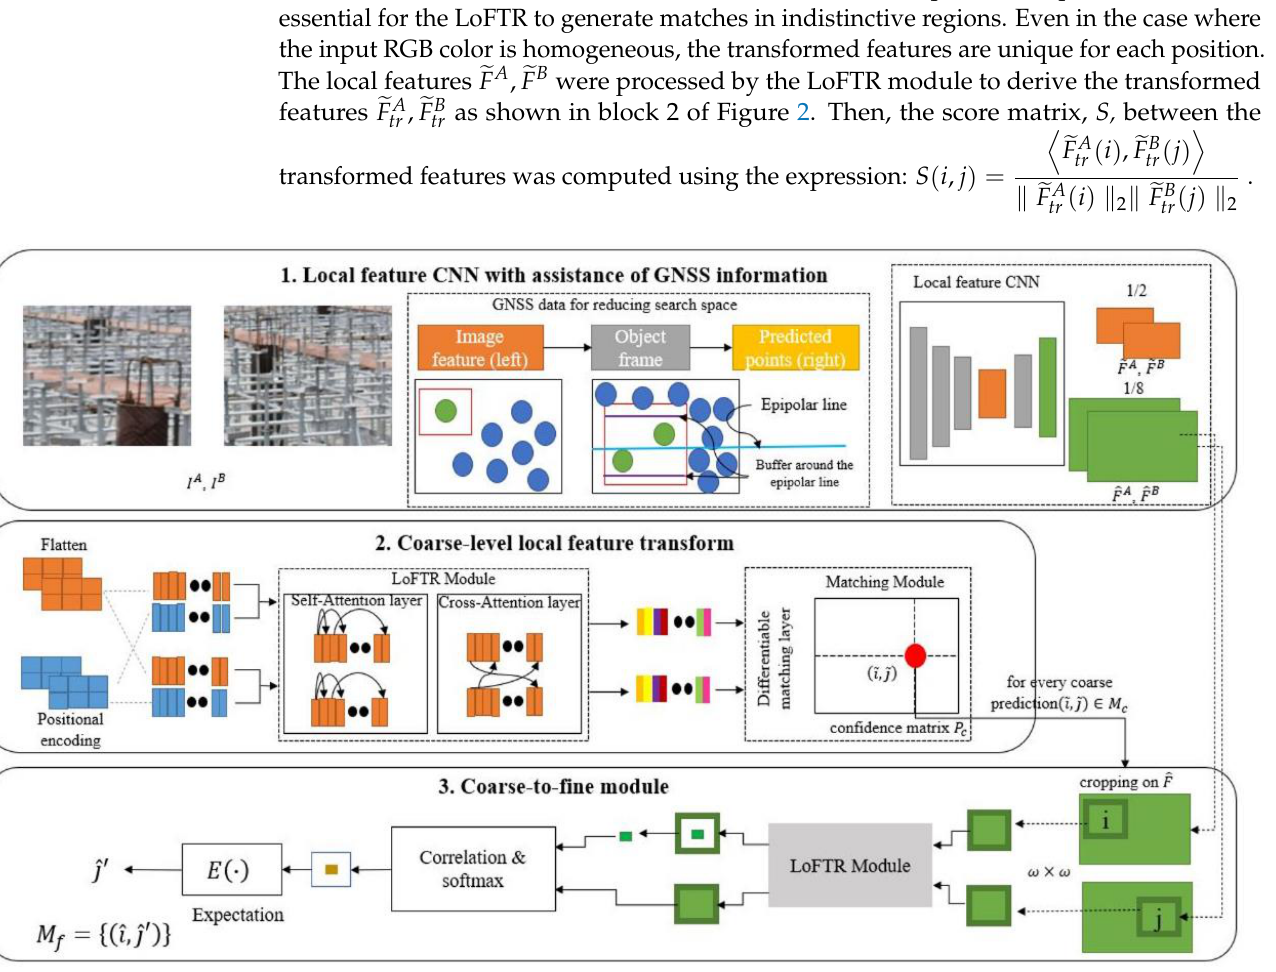
Figure 2. An overview of LoFTR